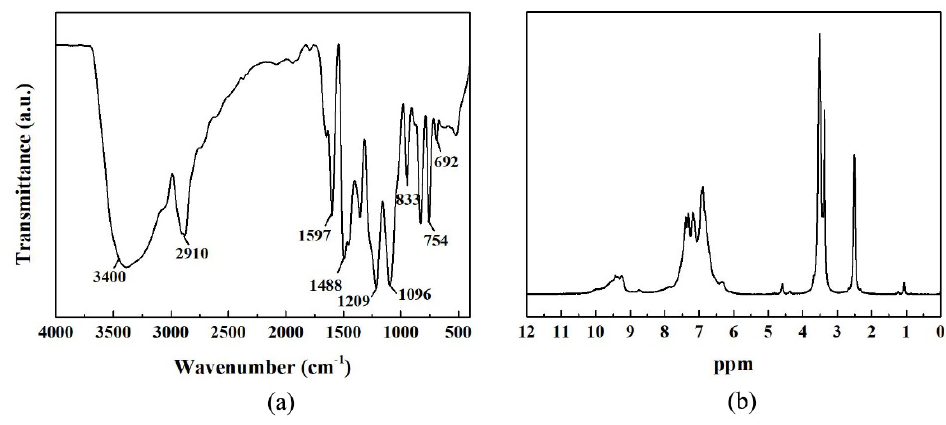
Figure 2. ( a ) FT-IR and ( b ) 1 H-NMR spectra of PP.